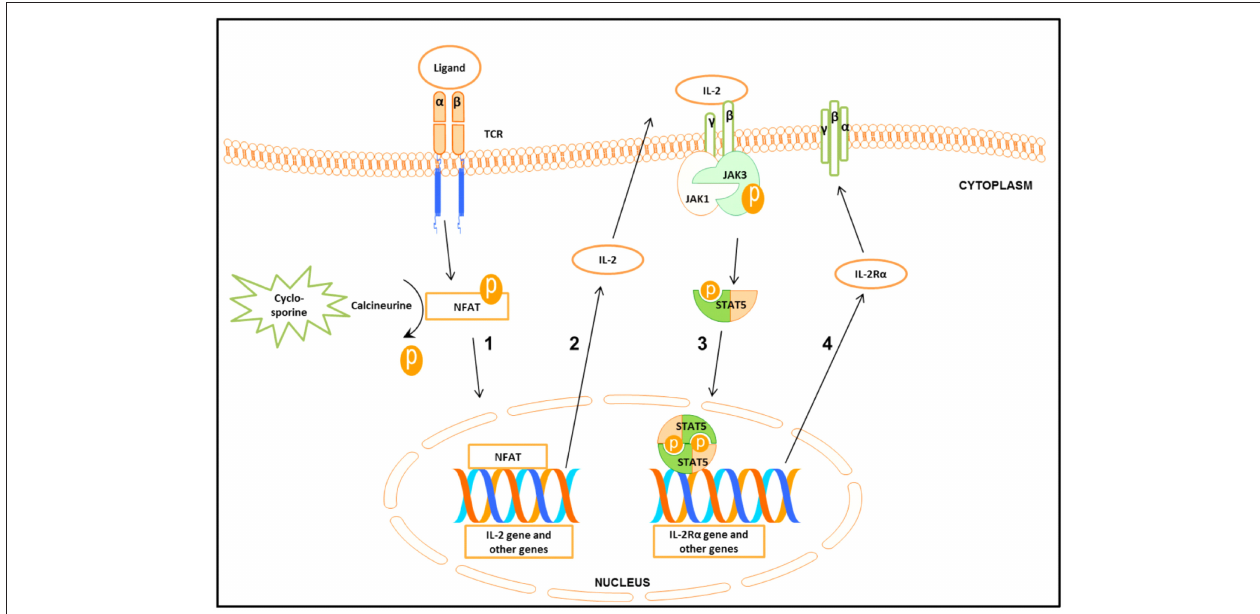
FIGURE 1 | Schematic presentation of the signal cascade following T cells stimulation (1) Binding of the ligand to the T cell receptor (TCR) leads to the activation of nuclear factor of activated T cell (NFAT). Cyclosporine by inhibiting calcineurine prevents activation of NFAT. Activated NFAT translocates to the nucleus where it activates target genes including IL-2. (2-3) Binding of IL-2 to IL-2 receptor βγ (IL-2R βγ ) leads to the activation of Janus kinase 3 (Jak3) which in turn phosphorylates signal transducer and activator of transcription 5 (STAT5). Phosphorylated STAT5 forms homo- and heterodimers that translocate to the nucleus, leading to the transcription of target genes including the IL-2R α gene. (4) IL-2R α together with IL-2R βγ forms the high affinity IL-2R βγα